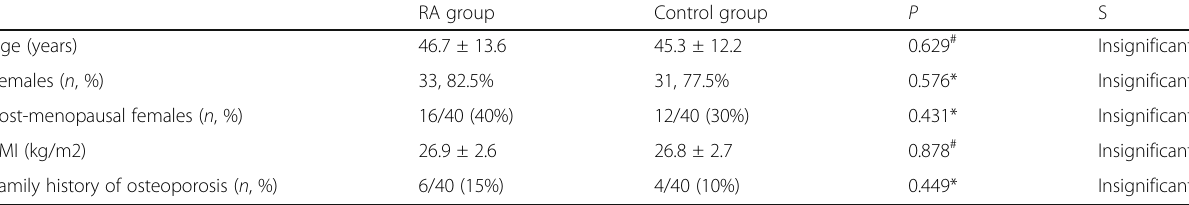
Table 1 The general characteristics of the RA patients and the controls